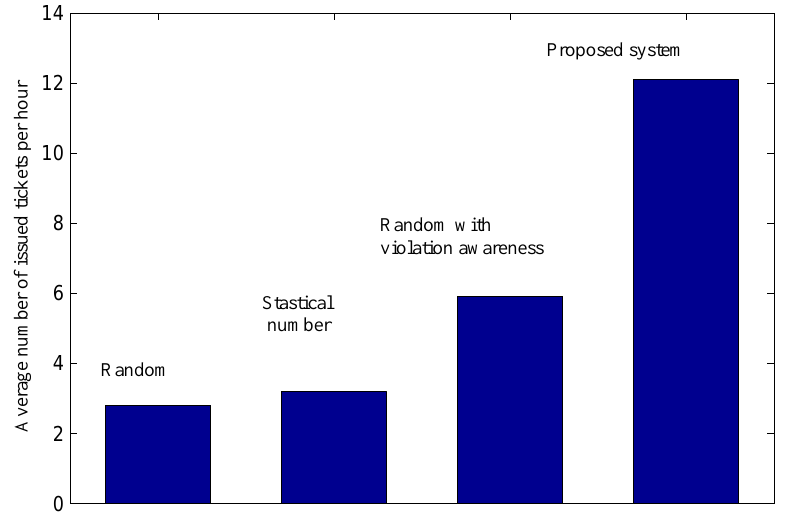
Figure 13. Average number of issued parking tickets per hour by a parking